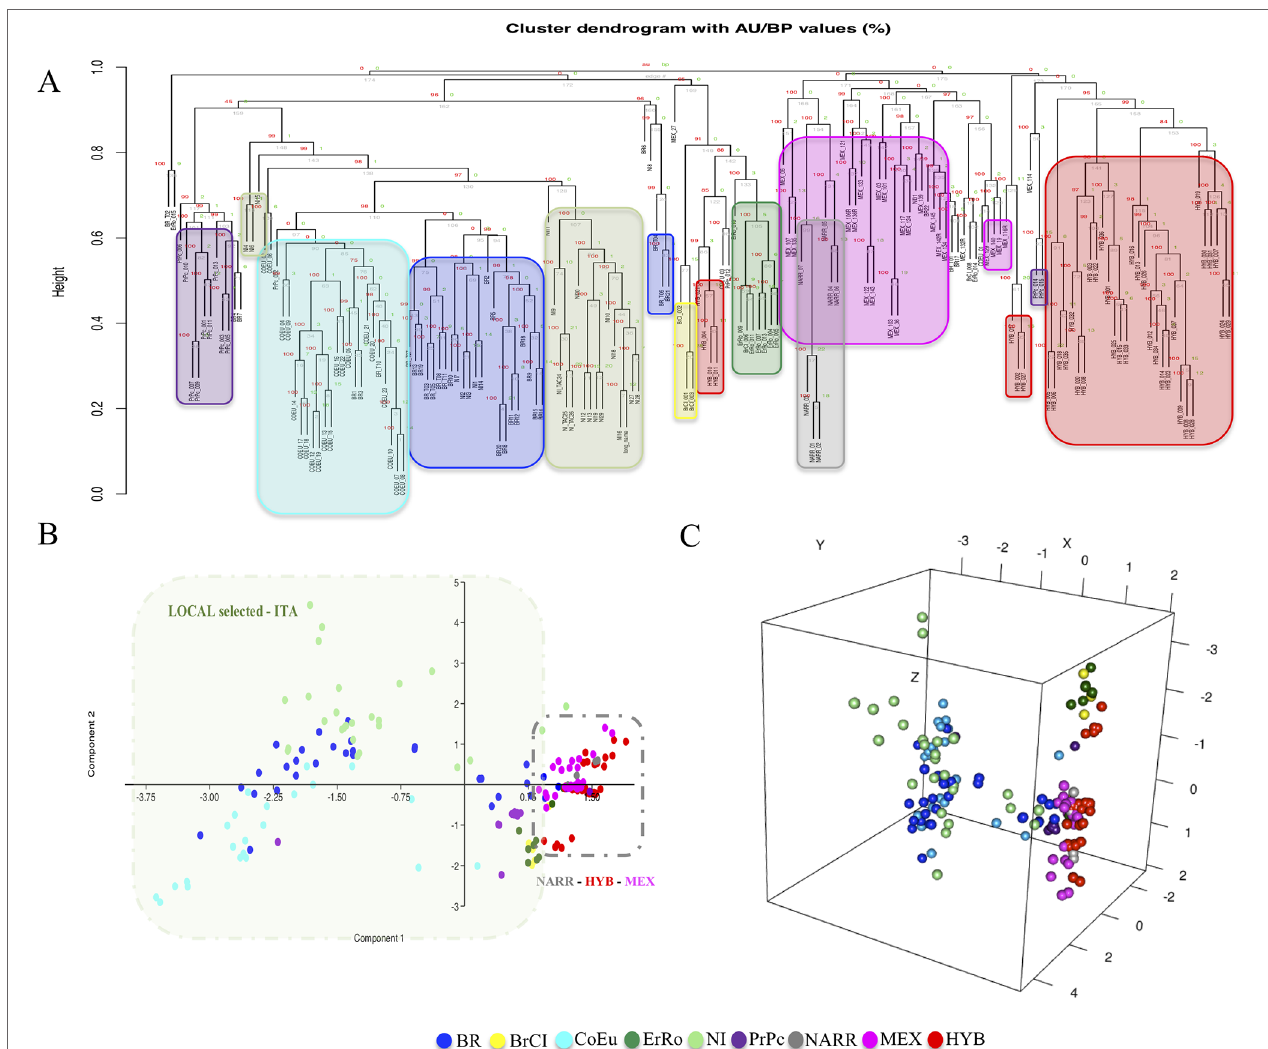
FIGURe 4 | Hierarchical clustering and PCAs based on CNVRs (CNV encoded as in matrix_2). Panels (A) , ( B) , and (C) are the dendrogram, the PCA-2D, and the PCA-3D, respectively.